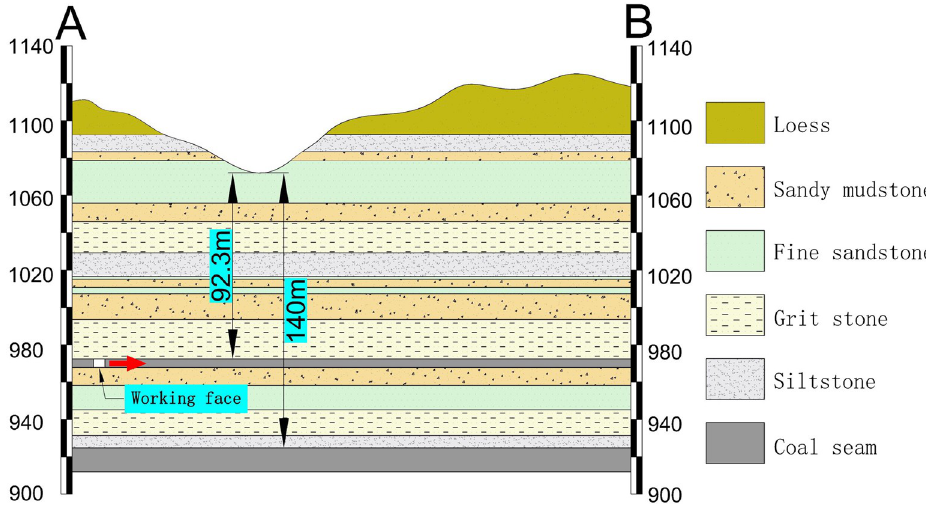
Fig 2. Schematic diagram of the AB section of the Gully